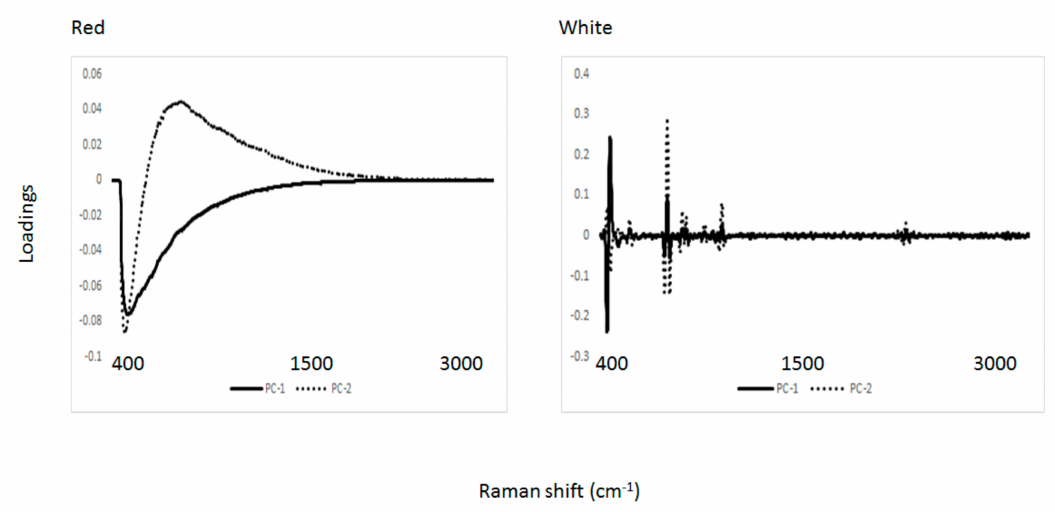
Figure 5. Loadings from the first two principal components derived from the principal component analysis of red and wine samples analyzed using Raman